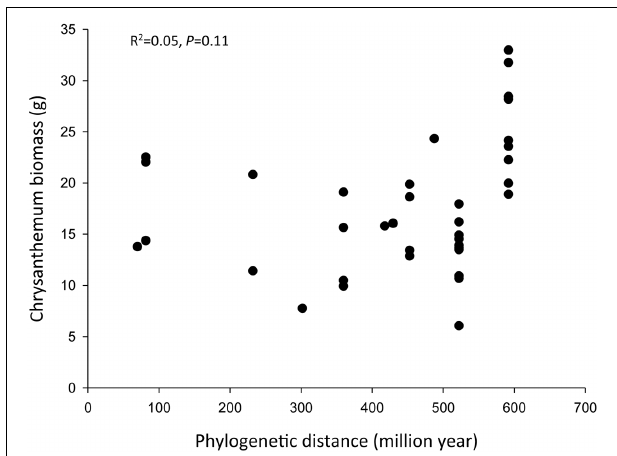
FIGURE 5 | Effects of phylogenetic relationships on the chrysanthemum biomass (aboveground biomass + belowground biomass). The phylogenetic distance is the distance of conditioning plant species to chrysanthemum. The phylogenetic relationship is based on a backbone tree of the recent phylogenetic hypothesis of the Angiosperm Phylogeny Group (R20120829 for plants). We used the BLADJ algorithm of the Phylocom to get branch lengths scaled to time, based on clade ages according to Wikström et al.